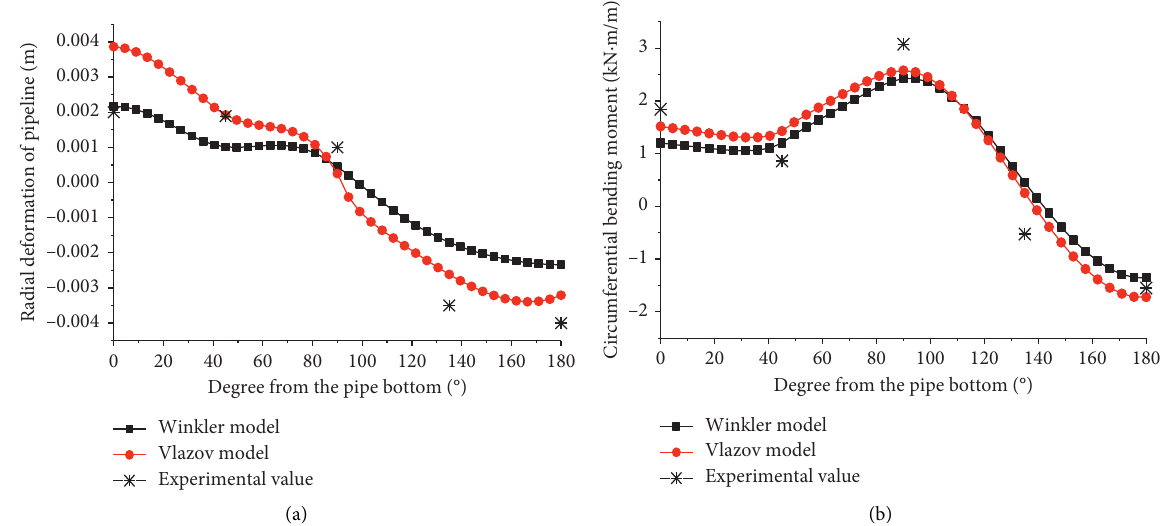
Figure 11: Comparison of the model calculation results and the experimental values (after polymer-repaired): (a) Radial deformation. (b) Circumferential bending moment.